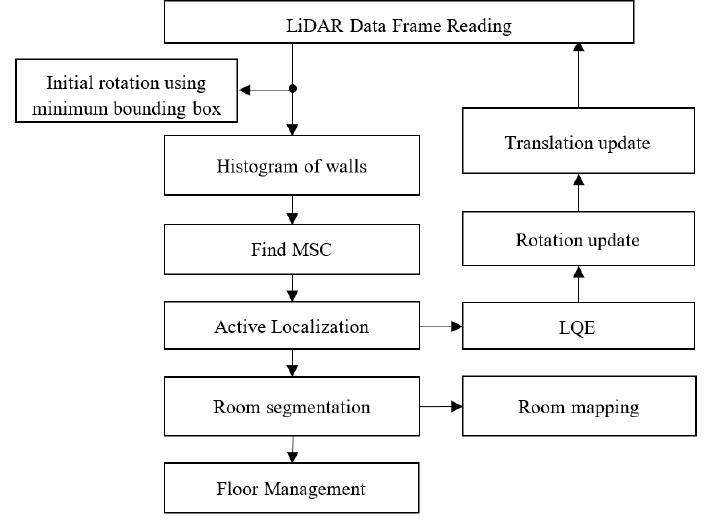
Figure 8. Flowchart of e-SLAM.